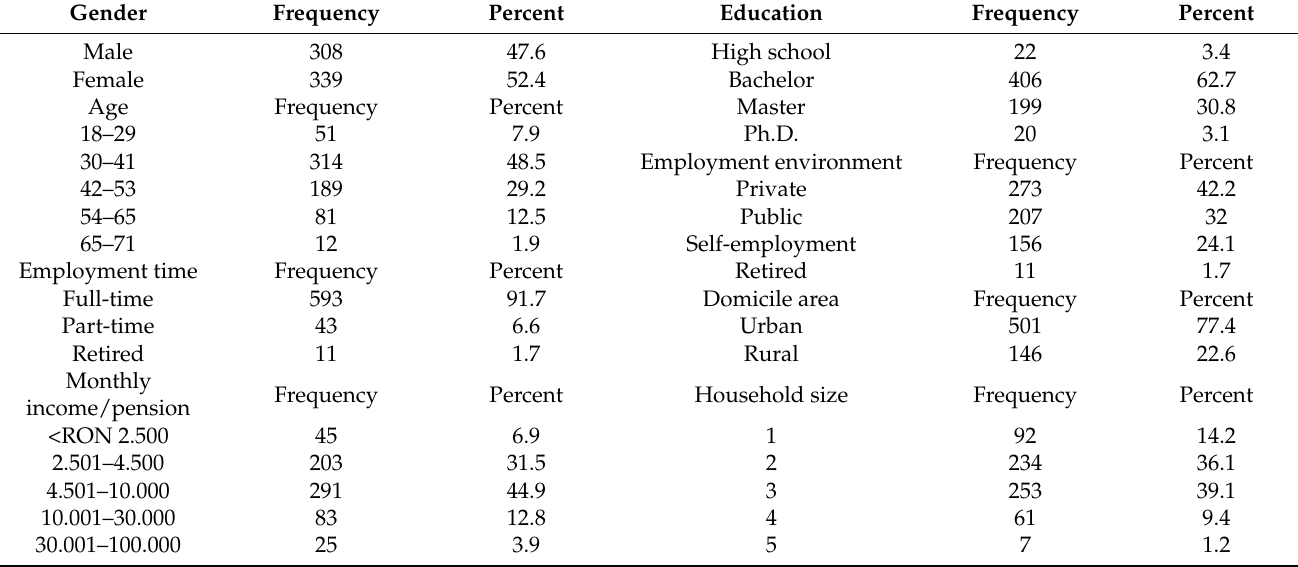
Table 1. Demographic details of the